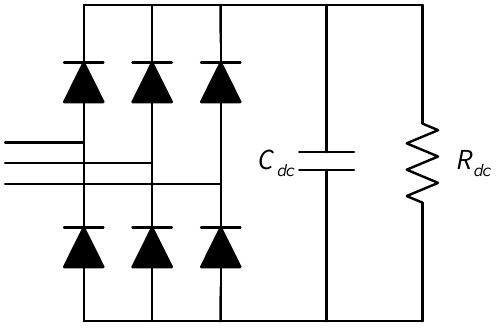
Figure 16. Nonlinear load circuit with a three phase diode